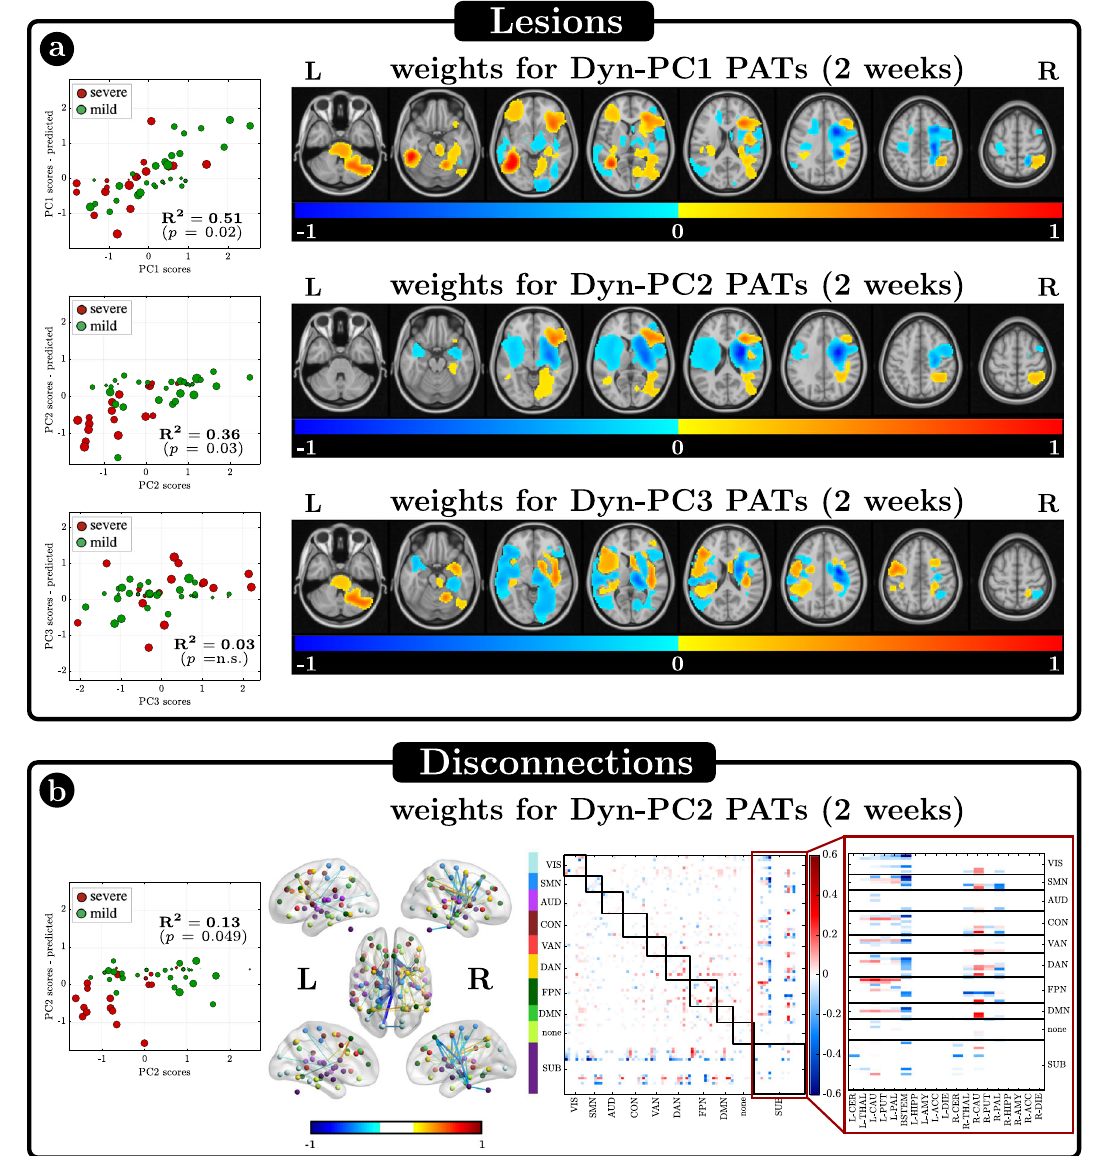
Fig. 6 | Relationship between dynamic principal components (Dyn-PCs) and lesionsordisconnections.a ResultsoftheRidgeRegression(RR)algorithmaimed at identifying possible existing relationships between the scores of the dynamical PCs and the anatomical lesions. On the left, the scatter plots between real and estimated values are shown, for the 3 Dyn-PCs. Each dot is a patient, whose stroke severity (severe or mild) is color-coded and whose lesion size is described by the dot dimension. R 2 is the amount of variance explained by each model, and p the model signi fi cance. Only Dyn-PC1 and Dyn-PC2 are signi fi cantly described by RR